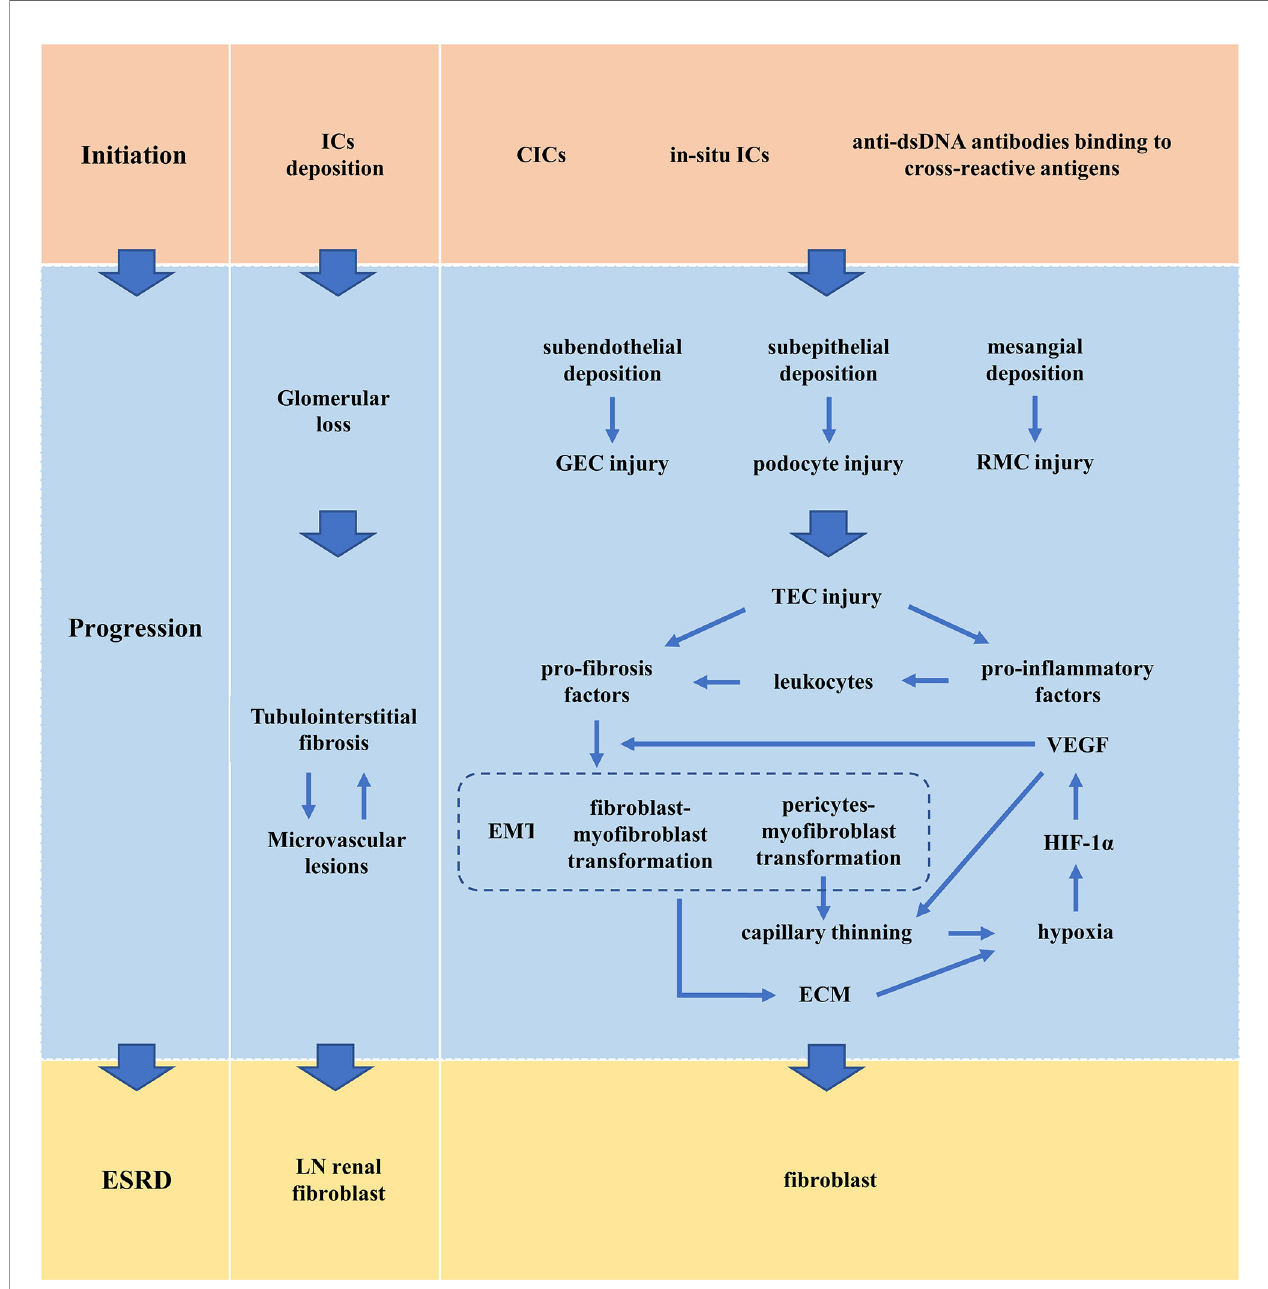
FIGURE 2 | Pathogenesis of LN. CIC, circulating immune complex; ECM, extracellular matrix; EMT, epithelial-to-mesenchymal transition; ESRD, end-stage renal disease; GEC, glomerular endothelial cell; HIF-1 a , hypoxia-inducing factor-1 a ; IC, immune complex; LN, lupus nephritis; RMC, renal mesangial cell; TEC, renal tubular epithelial cell; VEGF, vascular endothelial growth